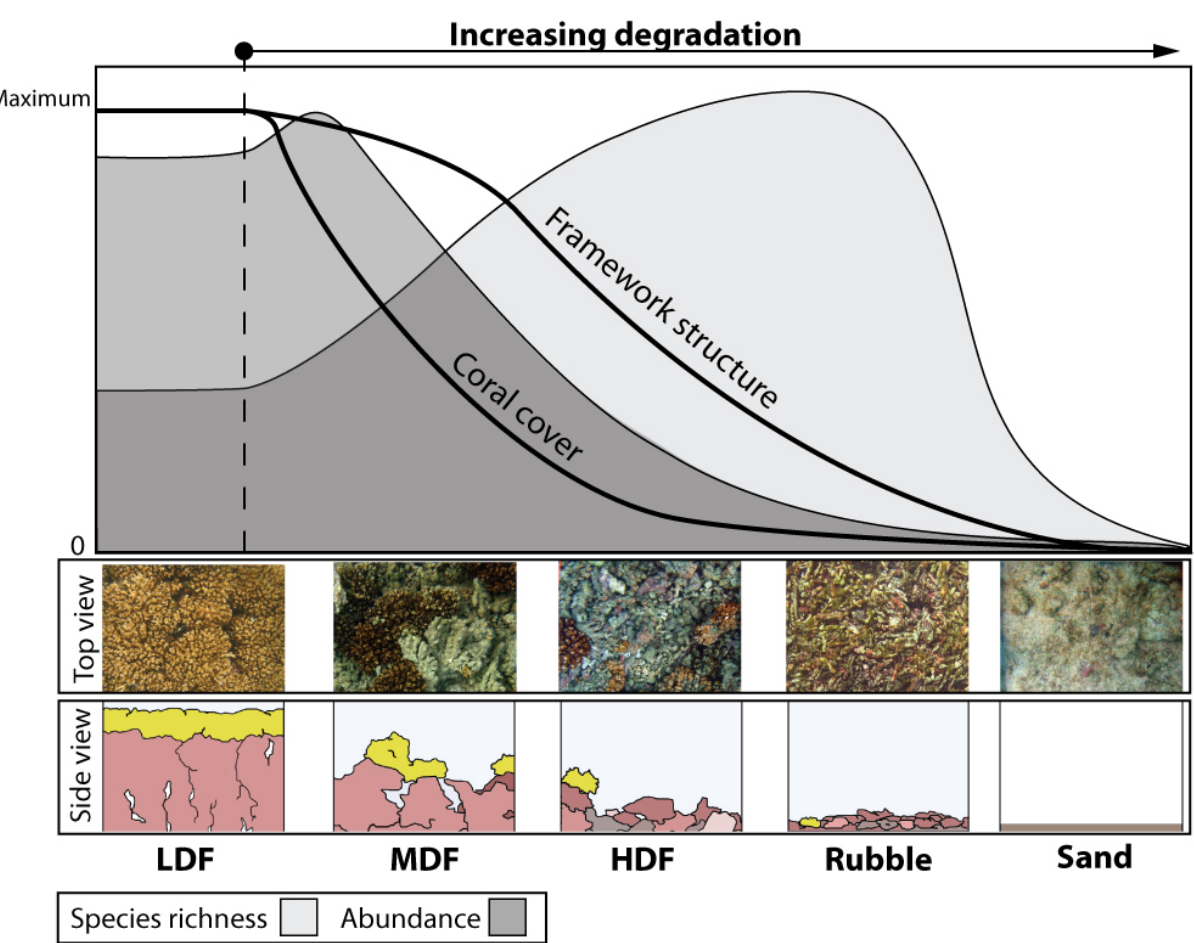
Figure 2. Response of coral reef cryptofaunal richness and community abundance to declines in coral cover and framework degradation. Communities modeled in this figure represent total numbers and species of cryptofauna, including those associated with both live and dead coral substrates. Solid lines represent changes in the habitat of cryptofauna following the progression of reef framework degradation. Coral cover refers to percent live coral cover, whereas framework structure refers to habitable framework depth and porosity [25]. Colored trajectories plot the species richness (light gray) and abundances (dark gray) of cryptofaunal communities. Different reef framework types defined in caption to Figure